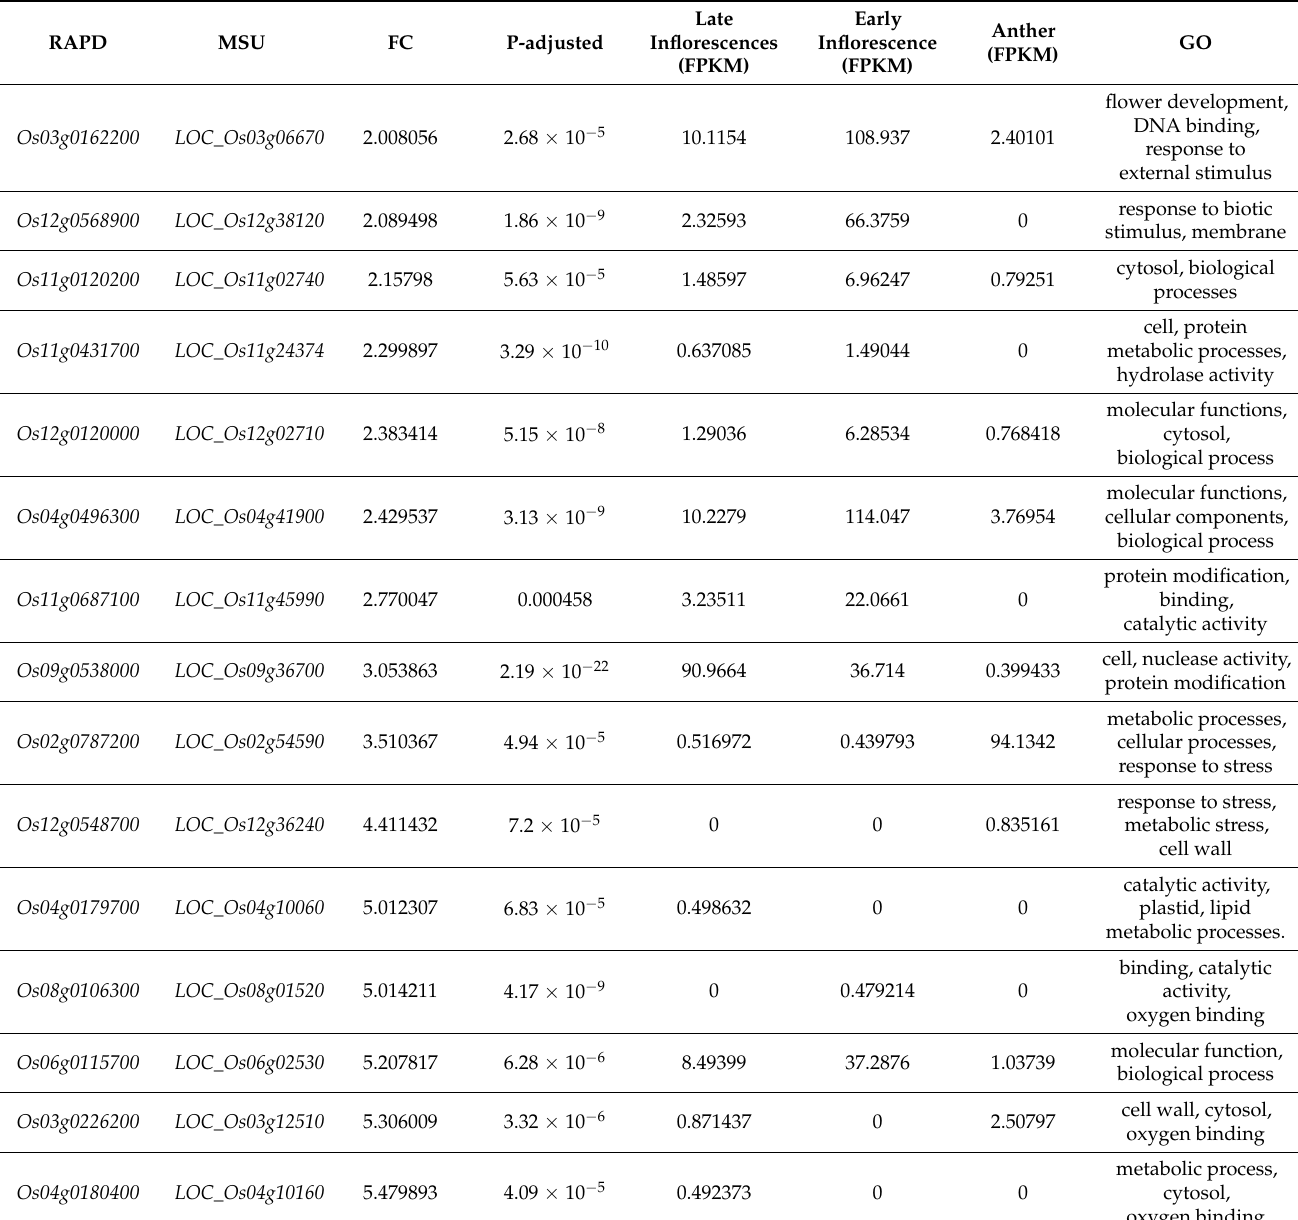
Table 2. List of upregulated DEGs, GO, and their expression spectrum in inflorescence and